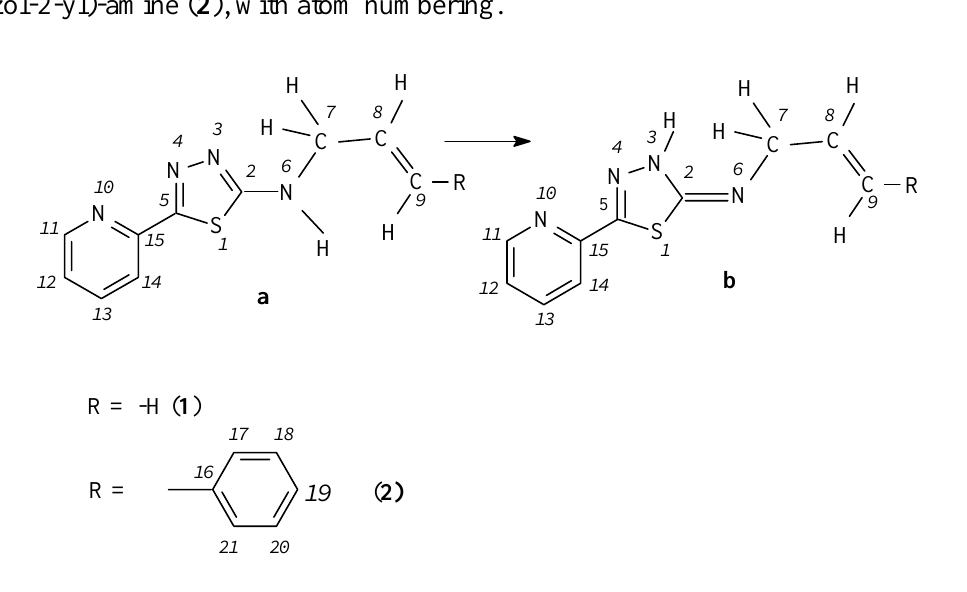
Figure 1. Tautomers a and b of allyl- ( 1 ) and 3-phenylallyl-(5-pyridin-2-yl- [1,3,4]thia- diazol-2-yl)-amine ( 2 ), with atom numbering.